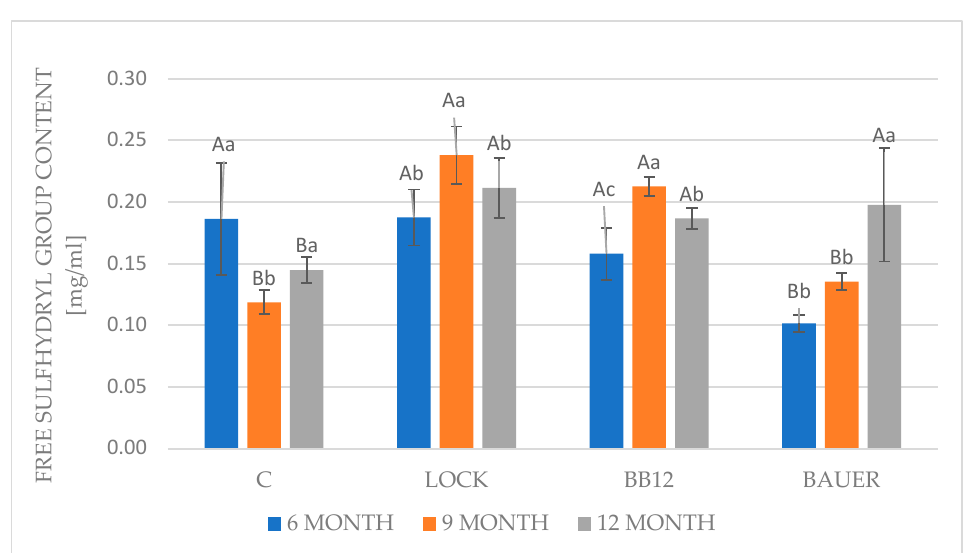
Figure 2. Free sulfhydryl group (SH) content in the fermented meat products during storage [C-control sample; LOCK-samples inoculated with Lacticaseibacillus rhamnosus LOCK900; BAUER-samples inoculated with Lactobacillus acidophilus Bauer Ł 0938; BB12-samples inoculated with Bifidobacterium animalis subsp. lactis BB12. (a–b) Within the same treatment, means followed by the same letter do not differ significantly ( p < 0.05). (A–B) Within the same aging time, means followed by the same letter do not differ significantly ( p < 0.05)].